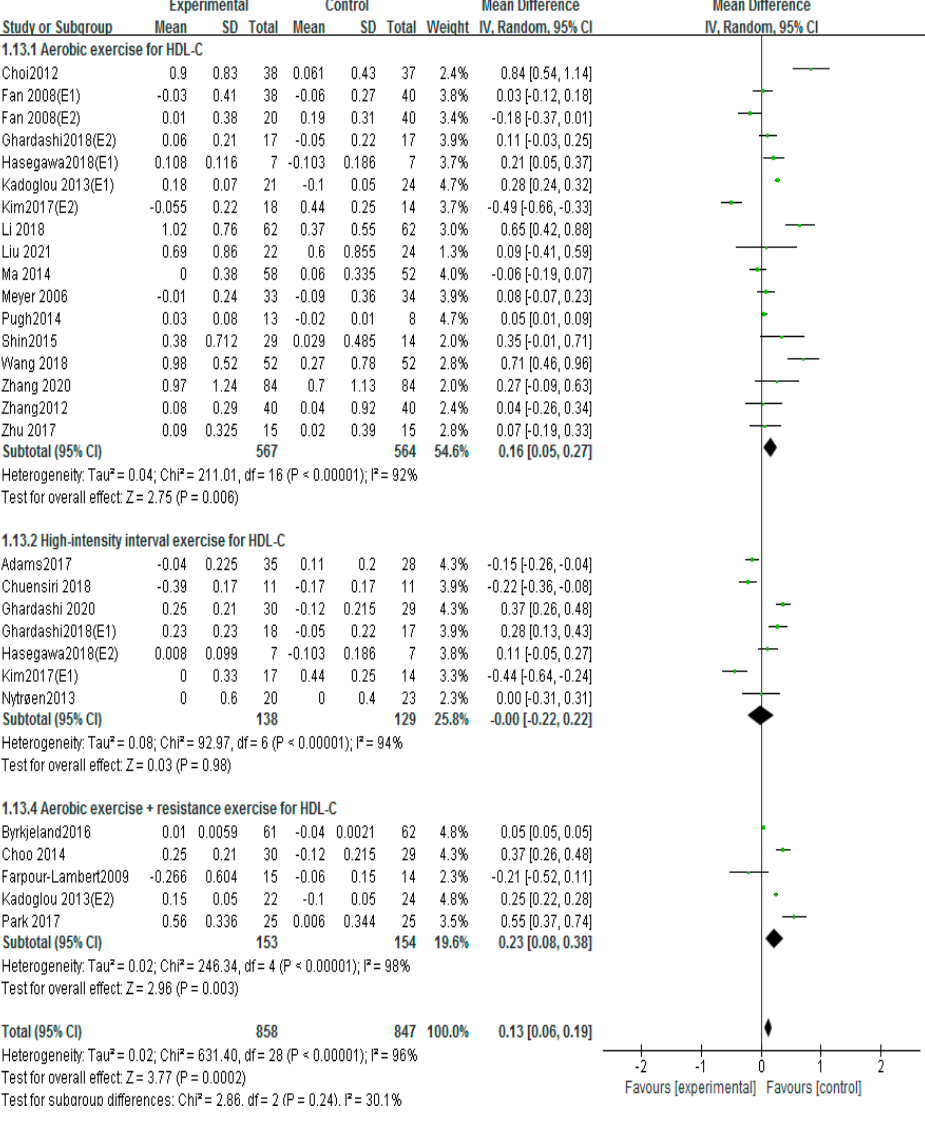
Figure 13. Egger’s test for evaluating the publication bias of TC. Figure 14. Funnel plot for evaluating the publication bias of LDL − C.